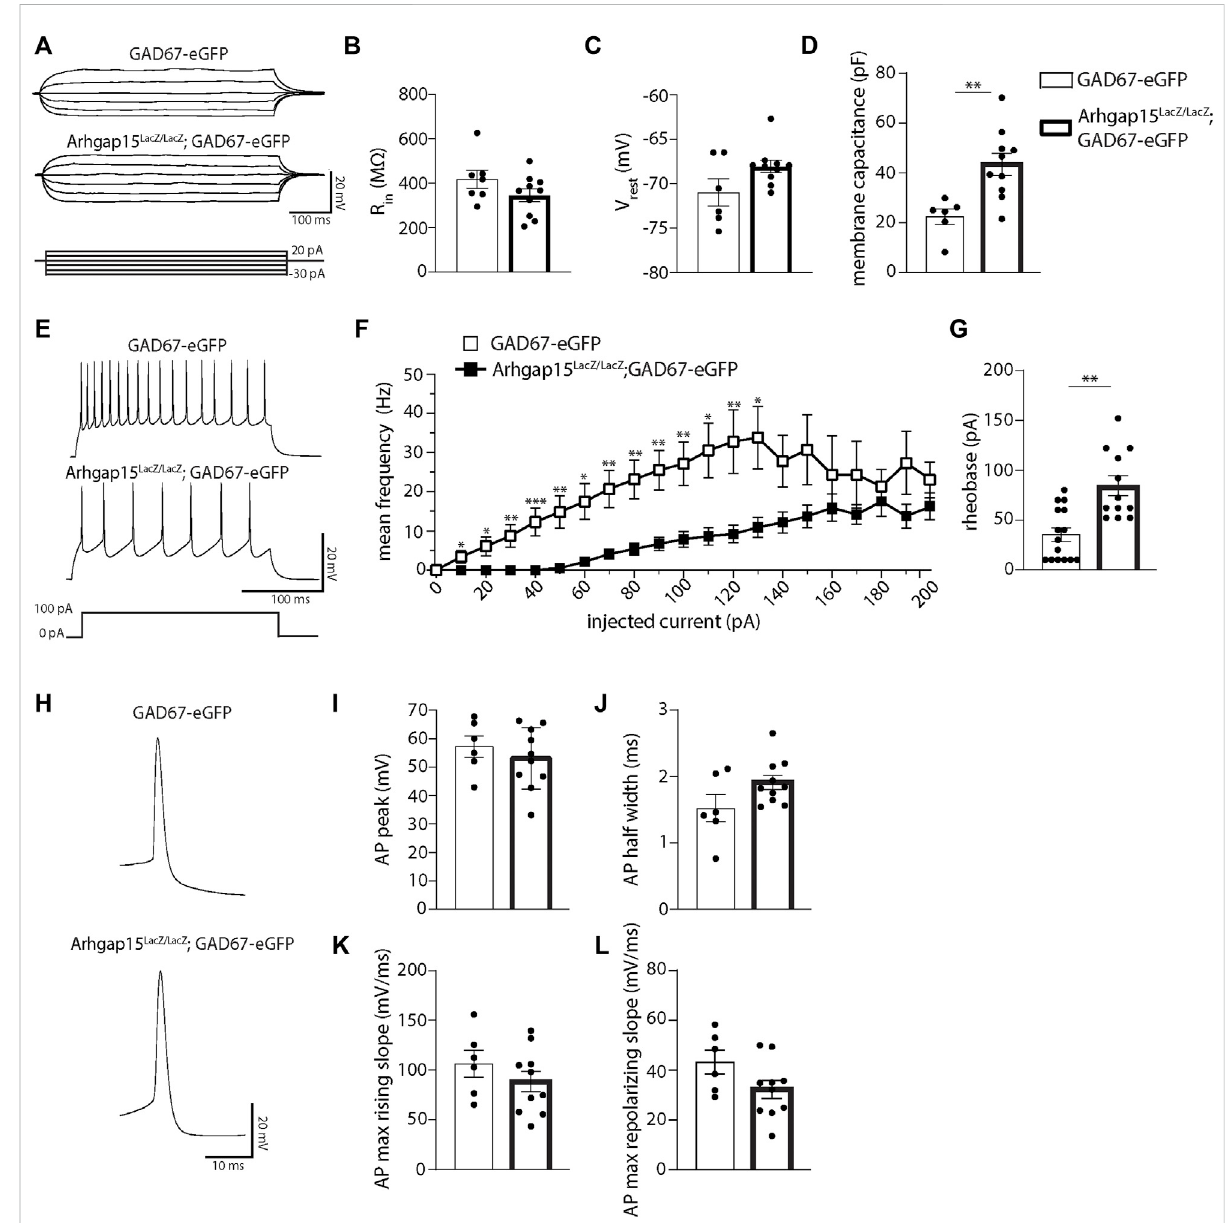
FIGURE 8 Whole-cellpatch-clampinacuteslices. (A) Representativewhole-cellcurrent-clamprecordingsofeGFP-positiveCINsinacuteslicesprepared fromadult GAD67-eGFP and Arhgap15 LacZ/LacZ ;GAD67-eGFP mice.Traceswereobtainedbyinjectingsixcurrentsteps(from-30to20 pA,with10 pA steps) lasting 500. ms. (B – D) Input resistance (R in ) (B; p = 0.16), resting membrane potential (V rest ) (C; p = 0.26), and membrane capacitance (D; p = 4 × 10 − 3 ) of GAD67-eGFP and Arhgap15 LacZ/LacZ ;GAD67-eGFP CINs. n = 6 cells from 4 GAD67-eGFP mice and 10 cells from 4 Arhgap15 LacZ/LacZ ; GAD67-eGFP mice. (E) Representative whole-cell current clamp recordings of action potentials (APs) evoked by 100 pA step current (bottom) for GAD67-eGFP (top)and Arhgap15 LacZ/LacZ ;GAD67-eGFP (middle) CINs. (F) Average fi ringfrequencyvs.currentrelationships recordedin GAD67-eGFP and Arhgap15 LacZ/LacZ ;GAD67-eGFP CINs in response to a set of injected current steps (from 0 to 200 pA, with 10 pA steps). p (from 0 to 200 pA)=0.99,0.02,0.01,0.005,6×10 − 4 ,0.006,0.01,0.003,0.003,0.002,0.005,0.01,0.007,0.01,0.06,0.09,0.35,0.27,0.47,0.12,0.38. (G) Average rheobase (minimum amount of current required to trigger an AP) in GAD67-eGFP and Arhgap15 LacZ/LacZ ;GAD67-eGFP CINs. p = 2 × 10 − 3 . n = 15 cells from 4 GAD67-eGFP mice and 12 cells from 4 Arhgap15 LacZ/LacZ ;GAD67-eGFP mice. (H) Representative APs recorded from GAD67-eGFP (top) and Arhgap15 LacZ/LacZ ;GAD67-eGFP (bottom) CINs. (I – L) Average AP peak (I; p = 0.45), half-width (J; p = 0.08), maximum risingslope(K; p = 0.31), and maximumrepolarizingslope (L; p = 0.88)ofevokedAPs in GAD67-eGFP and Arhgap15 LacZ/LacZ ;GAD67-eGFP CINs. n = 6 cells from 4 GAD67-eGFP mice and 10 cells from 4 Arhgap15 LacZ/LacZ ;GAD67-eGFP mice. p -values were calculated using unpaired two- tailed Student ’ st-test (B,D,I − L) and unpaired Mann – Whitneytest (C,F,G) . Data arepresented as mean± SEM.*= p < 0.05, ** = p < 0.01, ***= p <